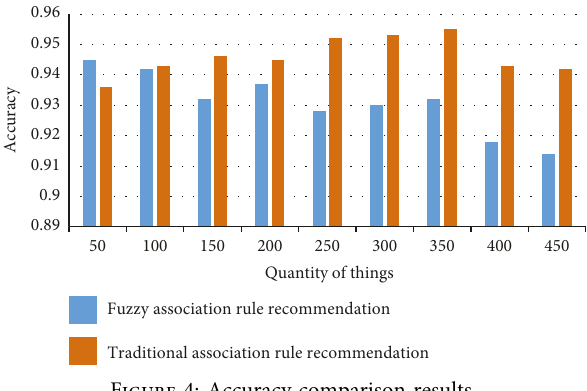
Figure 4: Accuracy comparison